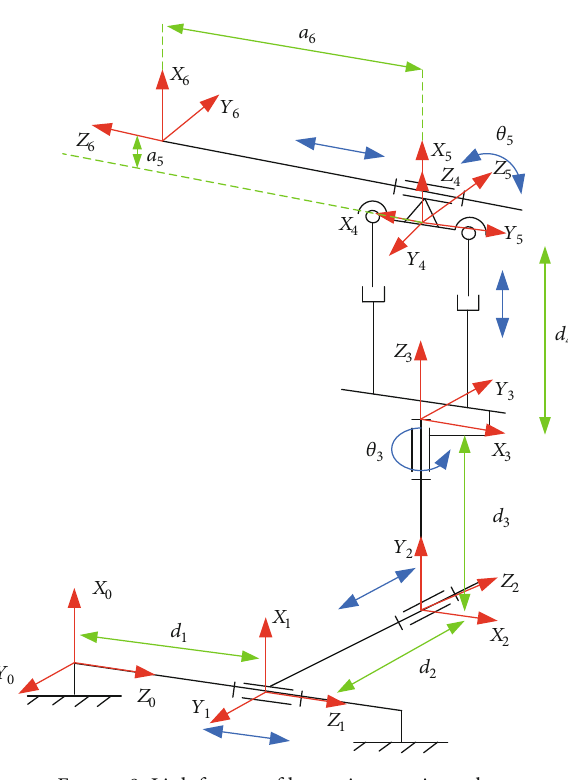
Figure 6: Z -direction positioning and pitching mechanism.